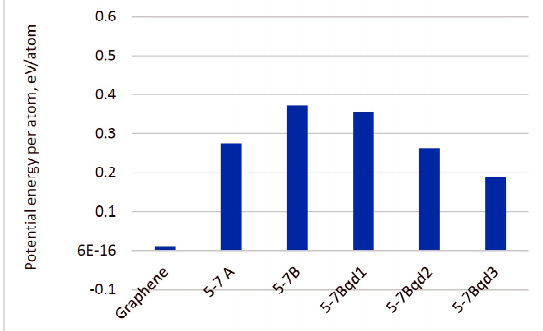
Fig. 7. Average specific potential energies of graphene crystals 5-7B, 5-7Bqd1, 5-7Bqd2, and